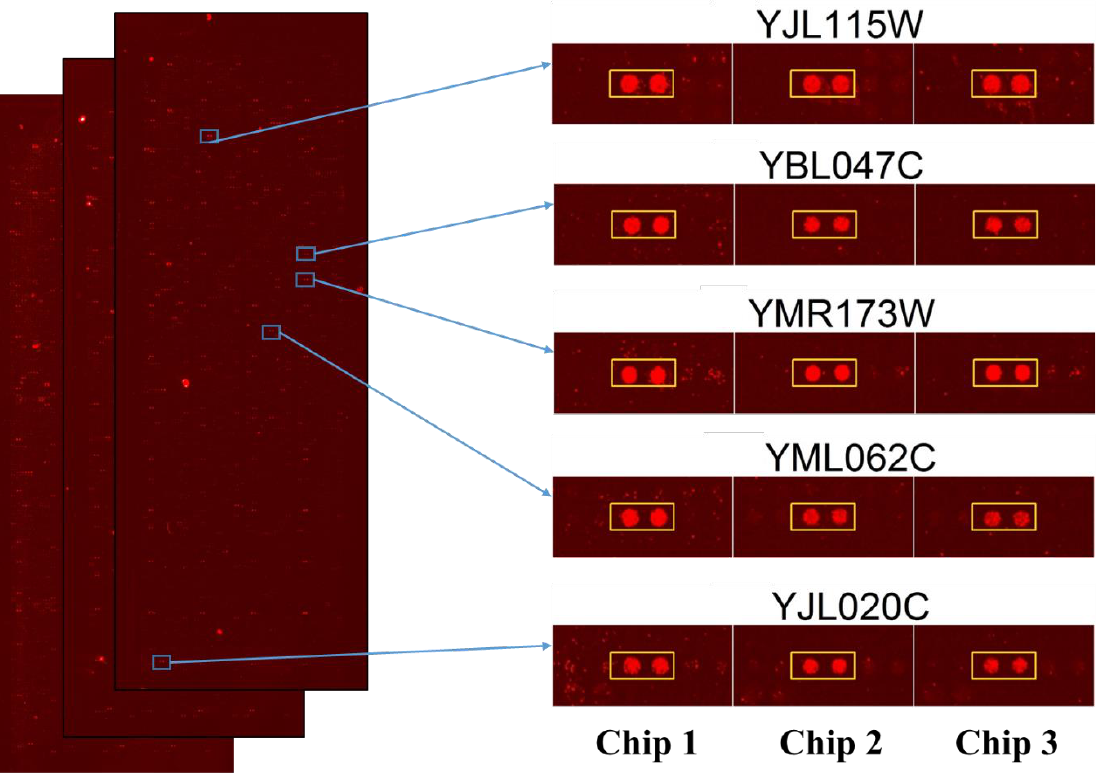
Figure 2. Image of Sub5 targets on Saccharomyces cerevisiae proteome microarrays and the enlarge images of representative protein targets. Images of Saccharomyces cerevisiae proteome microarrays probed with Sub5 and the representative protein target of Sub5 is shown in entire proteome, as well as individual enlarge images from the triplicate proteome microarray assays. The two sport represent the duplicate protein probed on Saccharomyces cerevisiae proteome microarrays (Chips). Chip 1, 2, and 3 represent the triplicate Saccharomyces cerevisiae proteome microarrays employed for Sub5 probing to systematically identify the protein targets. Red spots represent signal of Sub5 bound to immobilized Saccharomyces cerevisiae proteome.